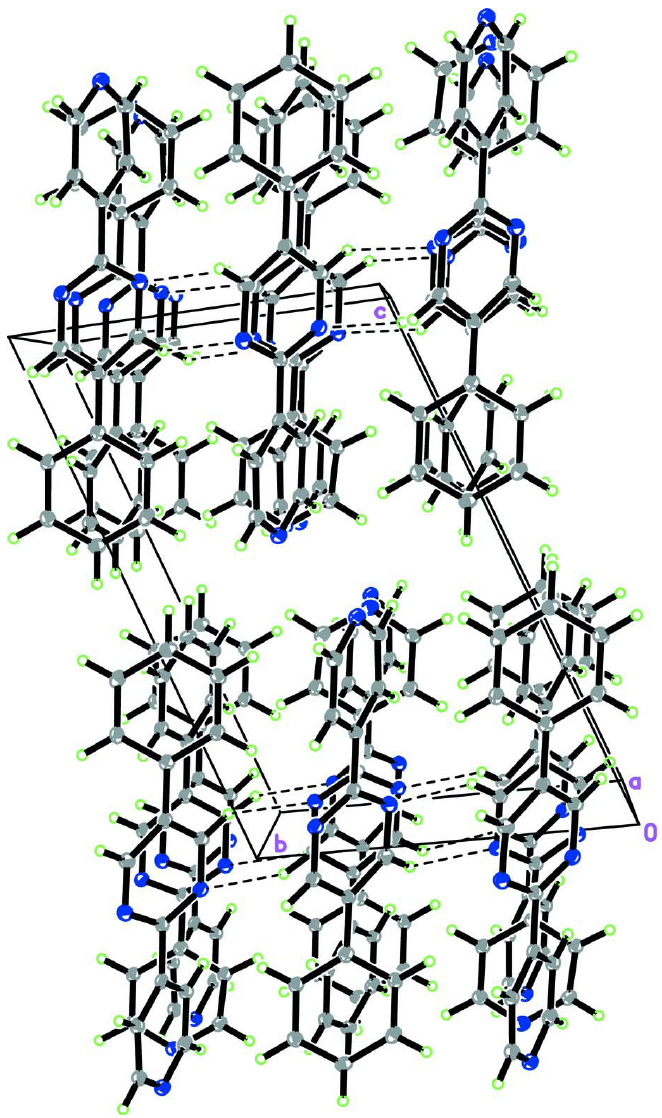
Figure 2 Part of the crystal structure of (3). Hydrogen bonds are shown as dashed lines. Ellipsoids are shown at the 30% probabilty